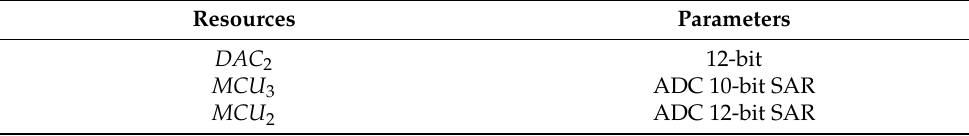
Table A1. List of elements from the circuit AGC in Figure